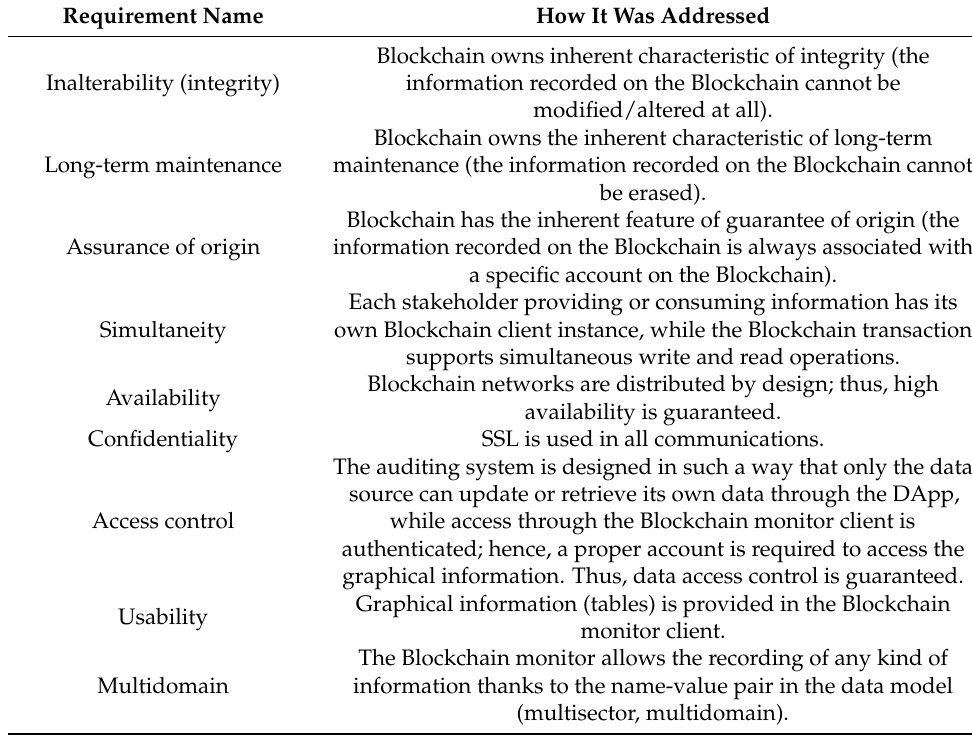
Table 3. Blockchain-based audit trail mechanism requirements